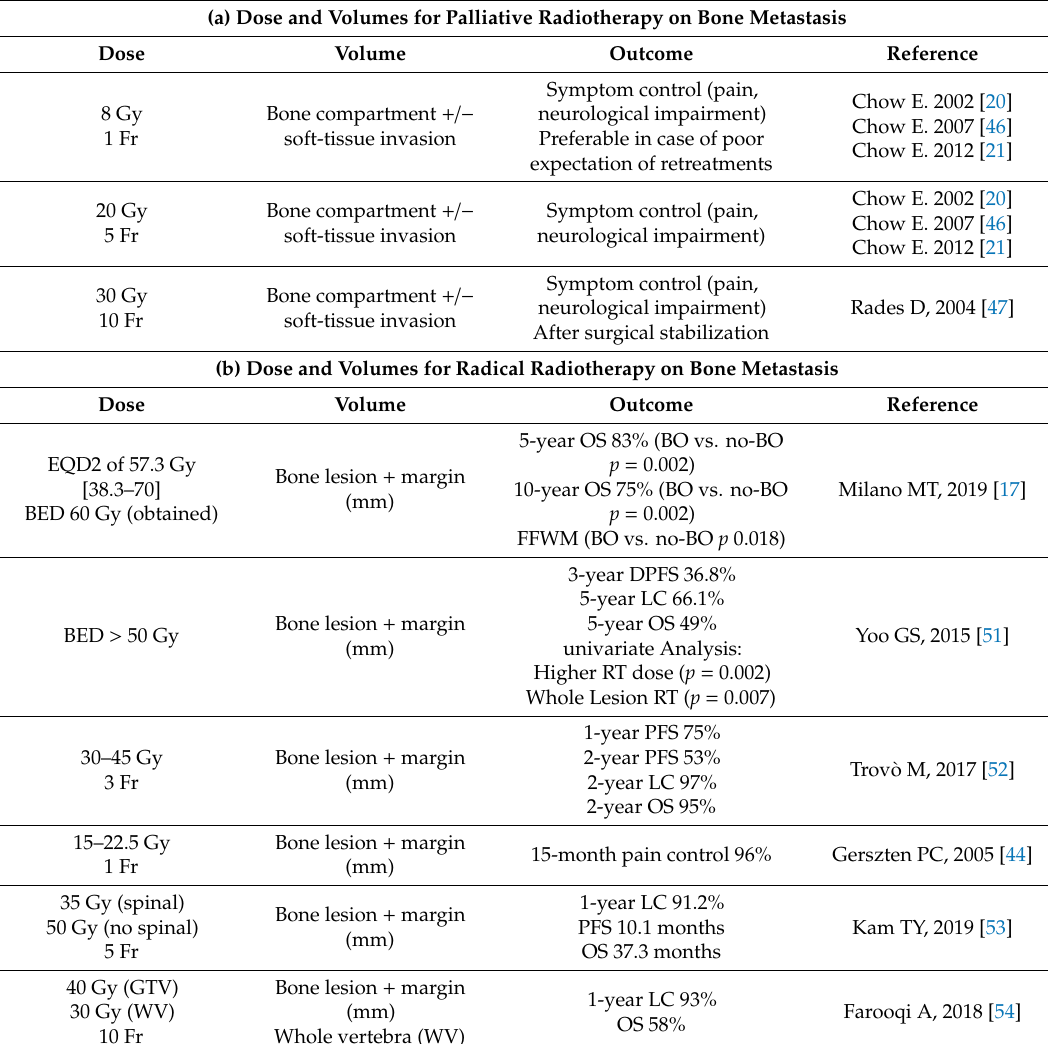
Table 1. Radiotherapy dose and volumes for bone metastasis